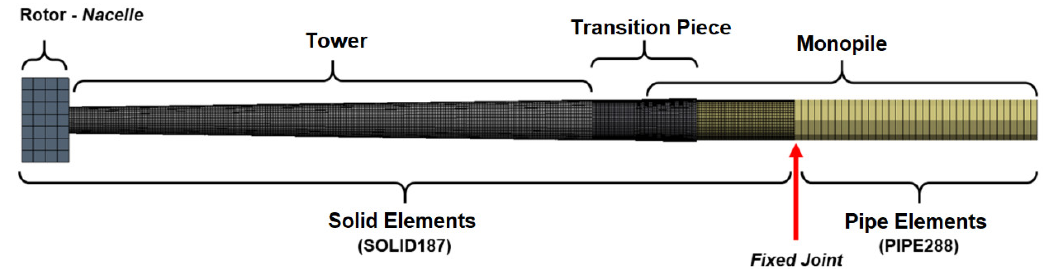
Figure 8. Final finite element mesh.